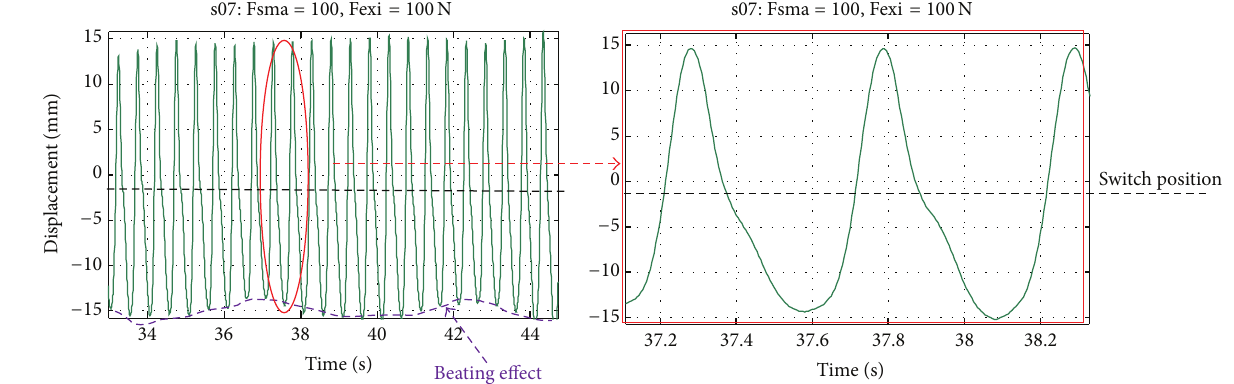
Figure 11: Nearly steady state response of SSI cable no. 1 at 7.2 m during a long shaking